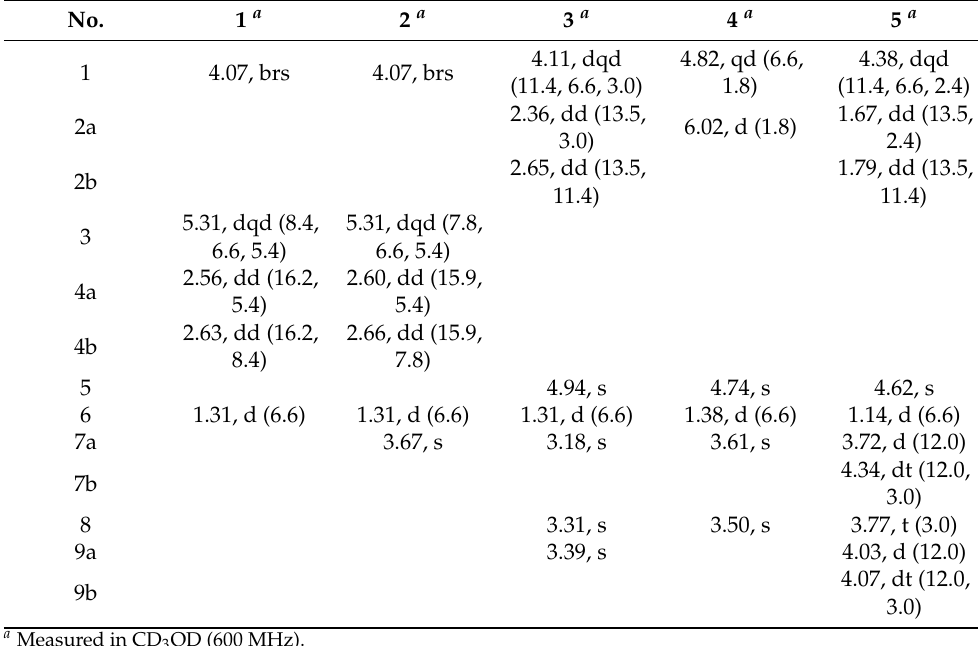
Table 2. 1 H NMR spectroscopic data for 1 – 5 ( δ in ppm, mult., J in Hz).